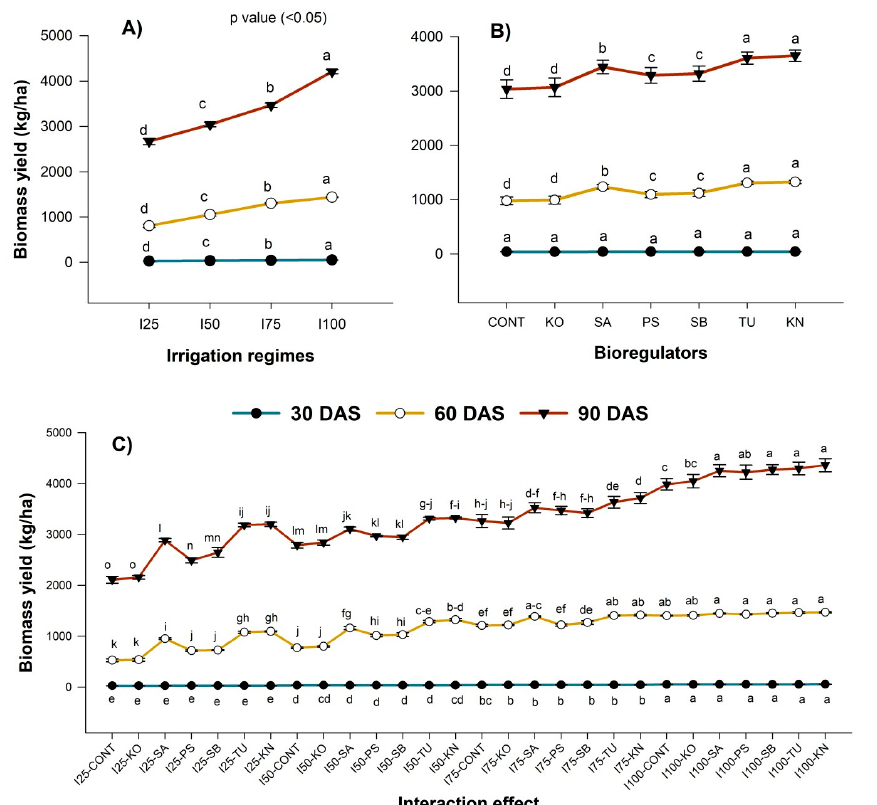
Figure 3. Effect of irrigation levels ( A ) and BRs ( B ) and interaction effect ( C ) on biomass production of chia at various growth stages. KO, SA, PS, SB, TU, KN, and no BR denote kaolin, salicylic acid, potassium silicate, sodium benzoate, thiourea, potassium nitrate, and control, respectively, while BRs and CPE denote bioregulators and cumulative pan evaporation, respectively.